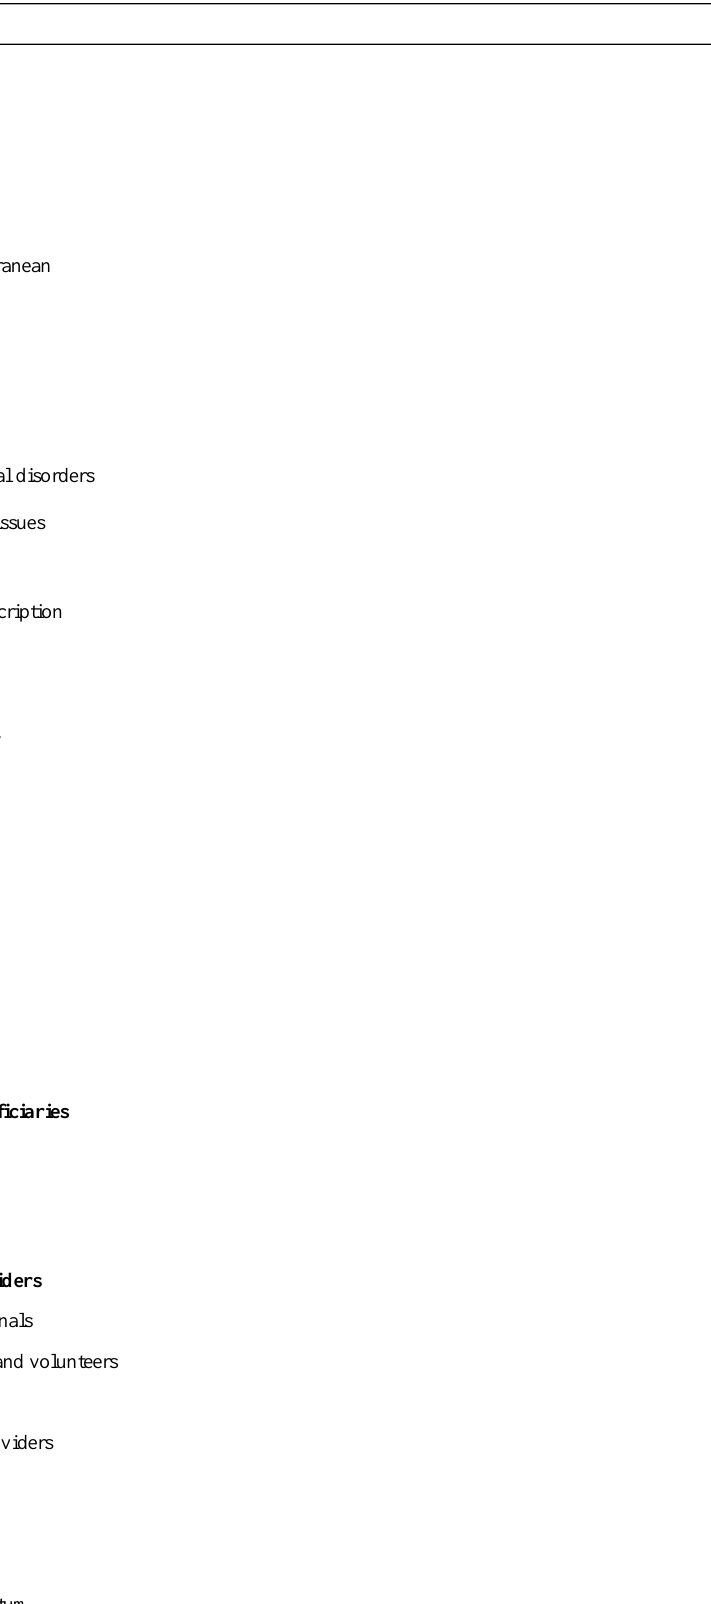
Table 1. Characteristics of included